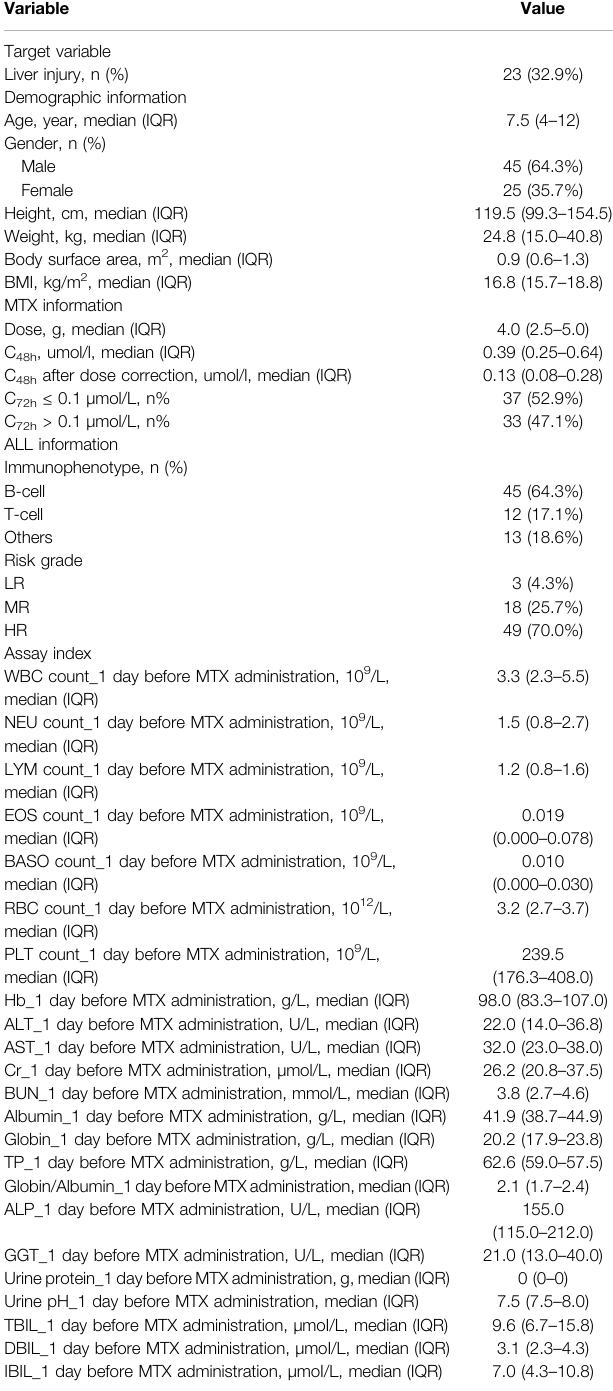
TABLE 1 | Baseline characteristics of study